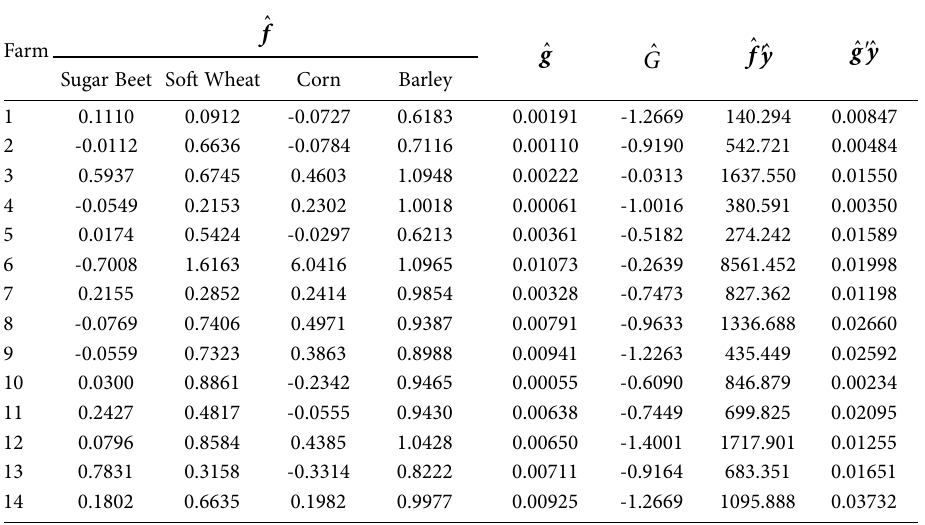
Table 3. Intercepts f ˆ , g ˆ and G ˆ matrix of the marginal cost and input demand functions.